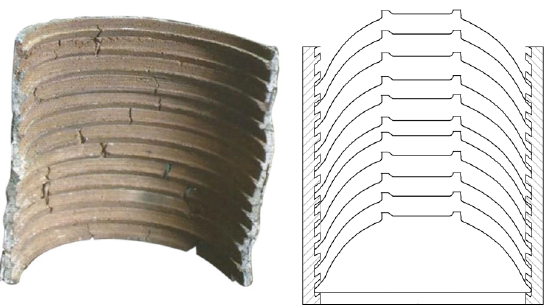
Figure 9. Sample and drawing of branch ring overburned excavated from Xiaopi kiln ceramics.